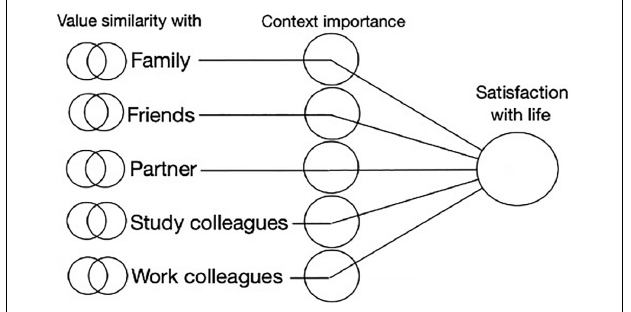
FIGURE 3 | Model on the relationship between value similarity and life satisfaction moderated by context importance (general importance and identity